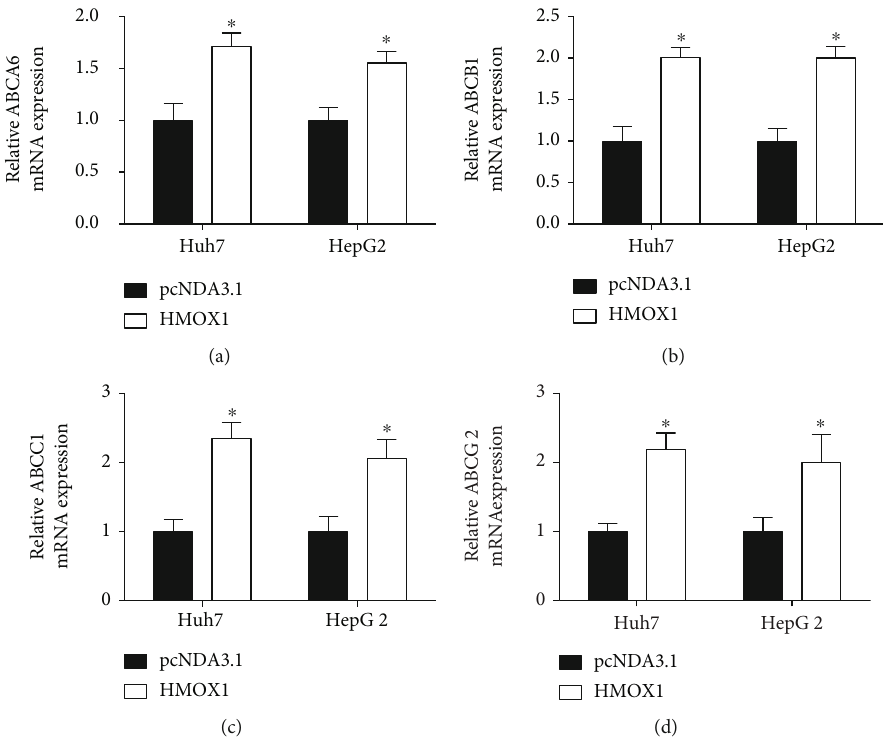
Figure 9: Overexpression of HMOX1 upregulated the expression of ABCA6, ABCB1, ABCC1, and ABCG2 in sorafenib-resistant cells. (a) Relative mRNA expression of ABCA6 in Huh7-SR and HepG2-SR cells after being transfected with pcDNA3.1 or pcDNA3.1-HMOX1. (b) Relative mRNA expression of ABCB1 in Huh7-SR and HepG2-SR cells after being transfected with pcDNA3.1 or pcDNA3.1-HMOX1. (c) Relative mRNA expression of ABCC1 in Huh7-SR and HepG2-SR cells after being transfected with pcDNA3.1 or pcDNA3.1-HMOX1. (d) Relative mRNA expression of ABCG2 in Huh7-SR and HepG2-SR cells after being transfected with pcDNA3.1 or pcDNA3.1-HMOX1. N = 3 . ∗ P < 0 : 05